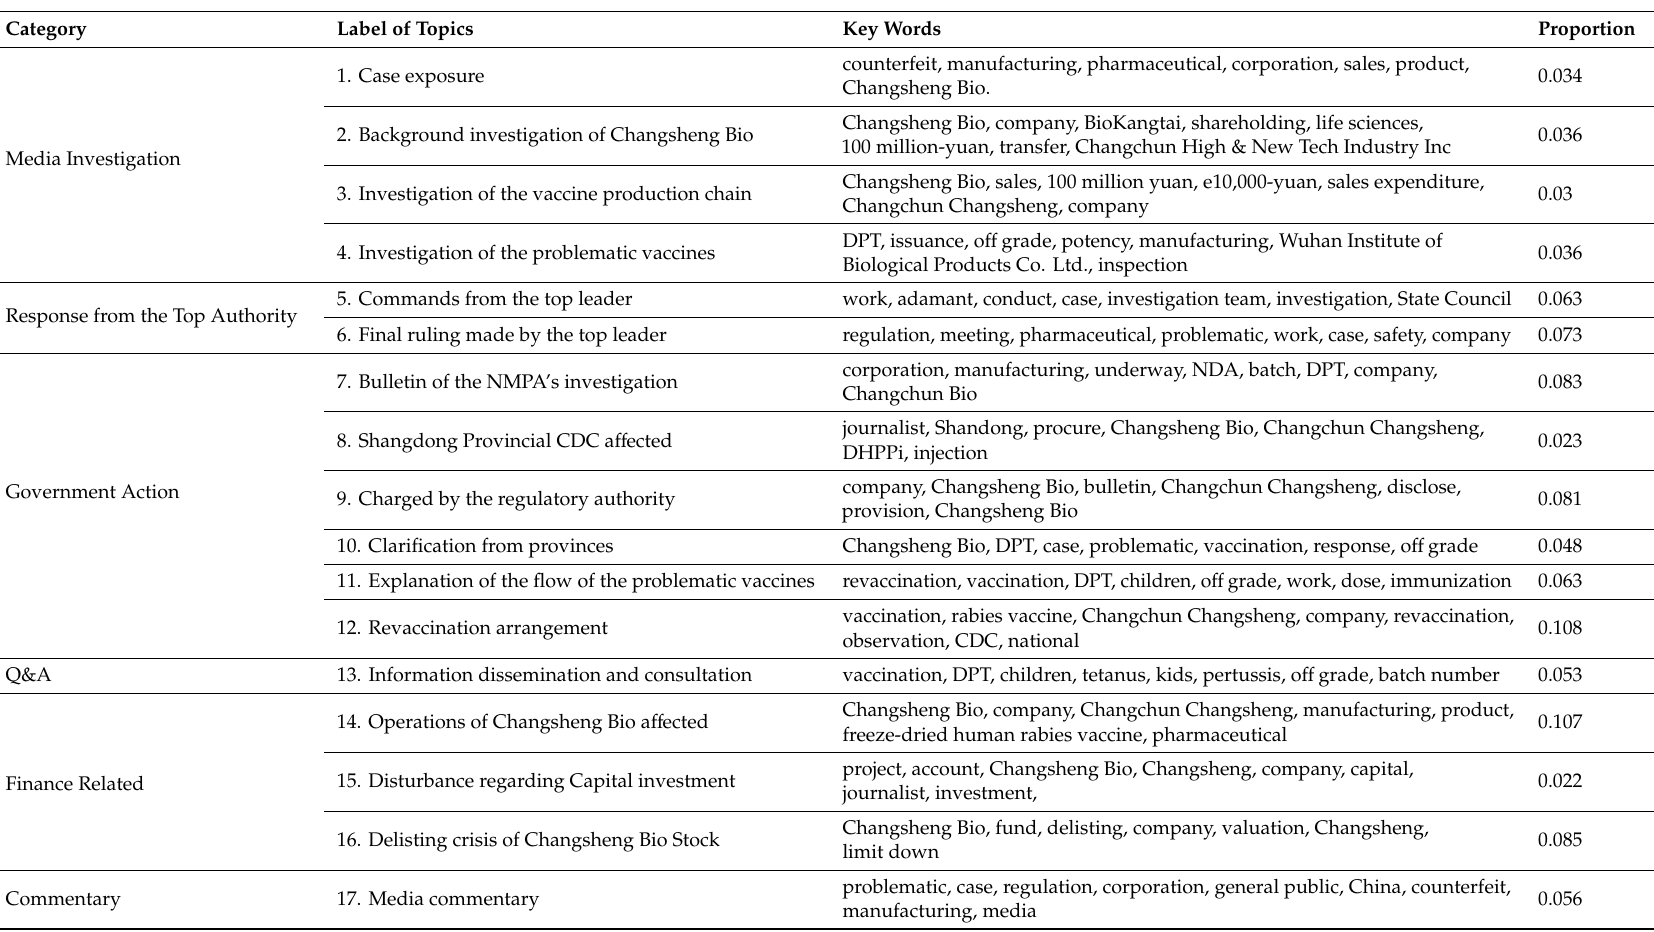
Table 1. Topics and keywords in the news reports on the Changsheng Bio